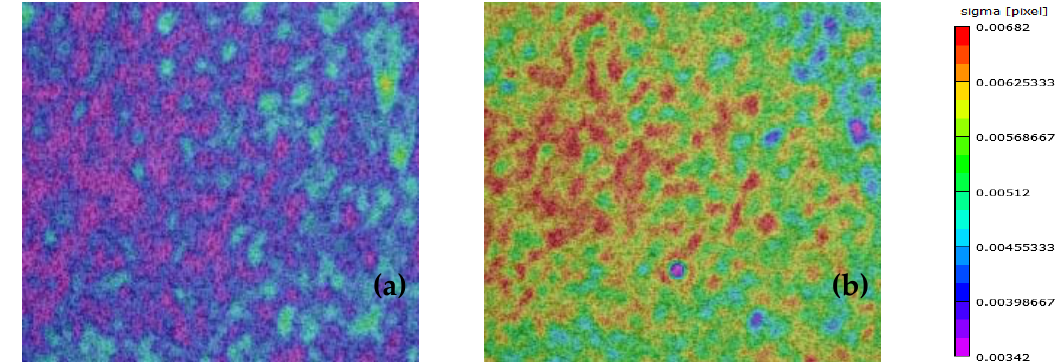
Figure 14. DIC σ pattern for a [0°/60°] 2s laminate ( a ) before and ( b ) after delamination.